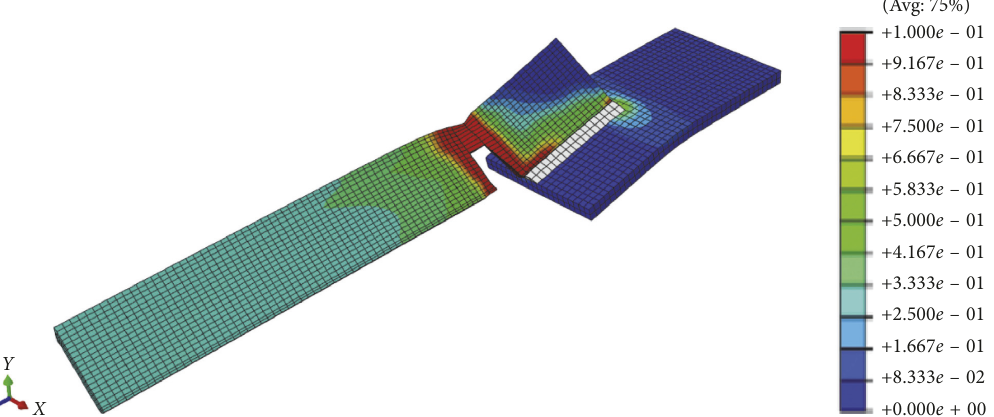
Figure 4: FE model showing fracture at the critical section.